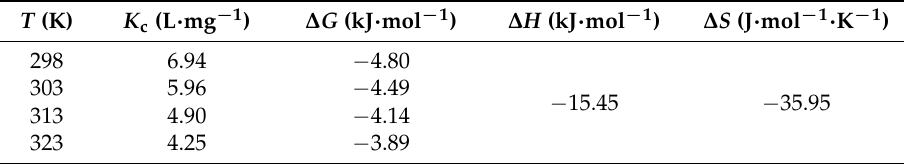
Table 4. Thermodynamic parameters for MB adsorption at different temperatures.